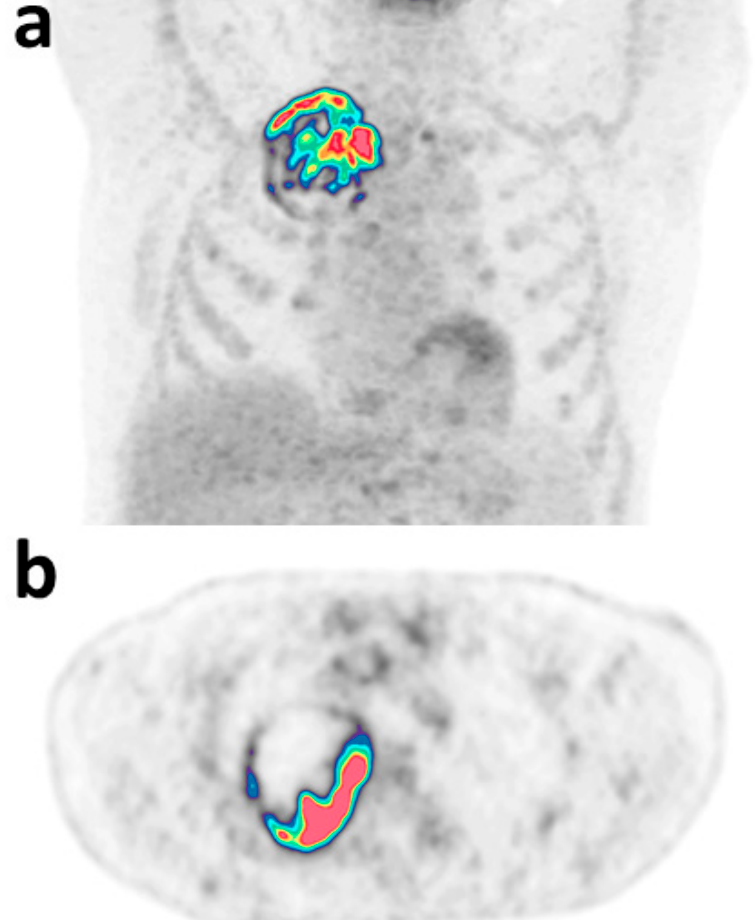
Figure 5. Representative maximum intensity projection ( a ) and axial ( b ) images of true-positive patients with MET gene alteration and a pred.score equal to 0.92. Model variables were: age = 70 years, sex = male, smoking history = yes, AJCC stage: IIIA, excessKurtosis _HISTO = 11.72, sphericity _SHAPE = 0.83, variance _GLCM = 24.40, correlation _GLCM = 0.87, LZE _GLZLM = 9188.94, GLNU _GLZLM = 76.81.